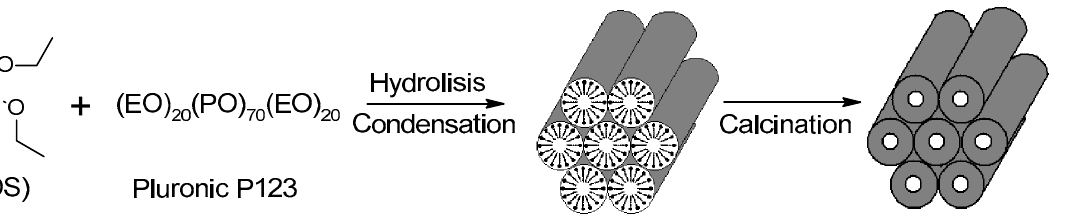
Figure 3. General scheme for the preparation of SBA-15.